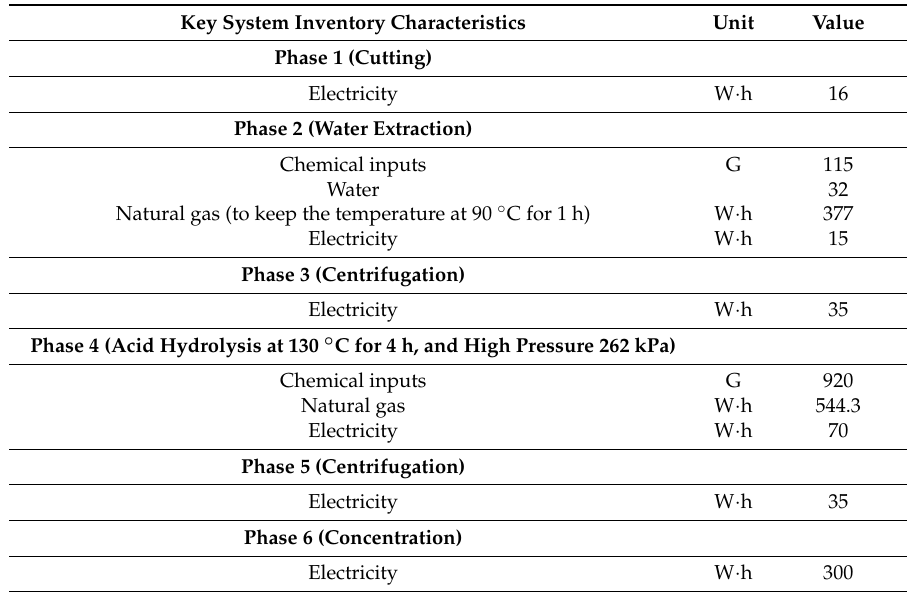
Table 4. Key characteristics of the production process of protein hydrolysate-based biostimulant from leather waste (data refer to the production of 1 kg protein hydrolysate).